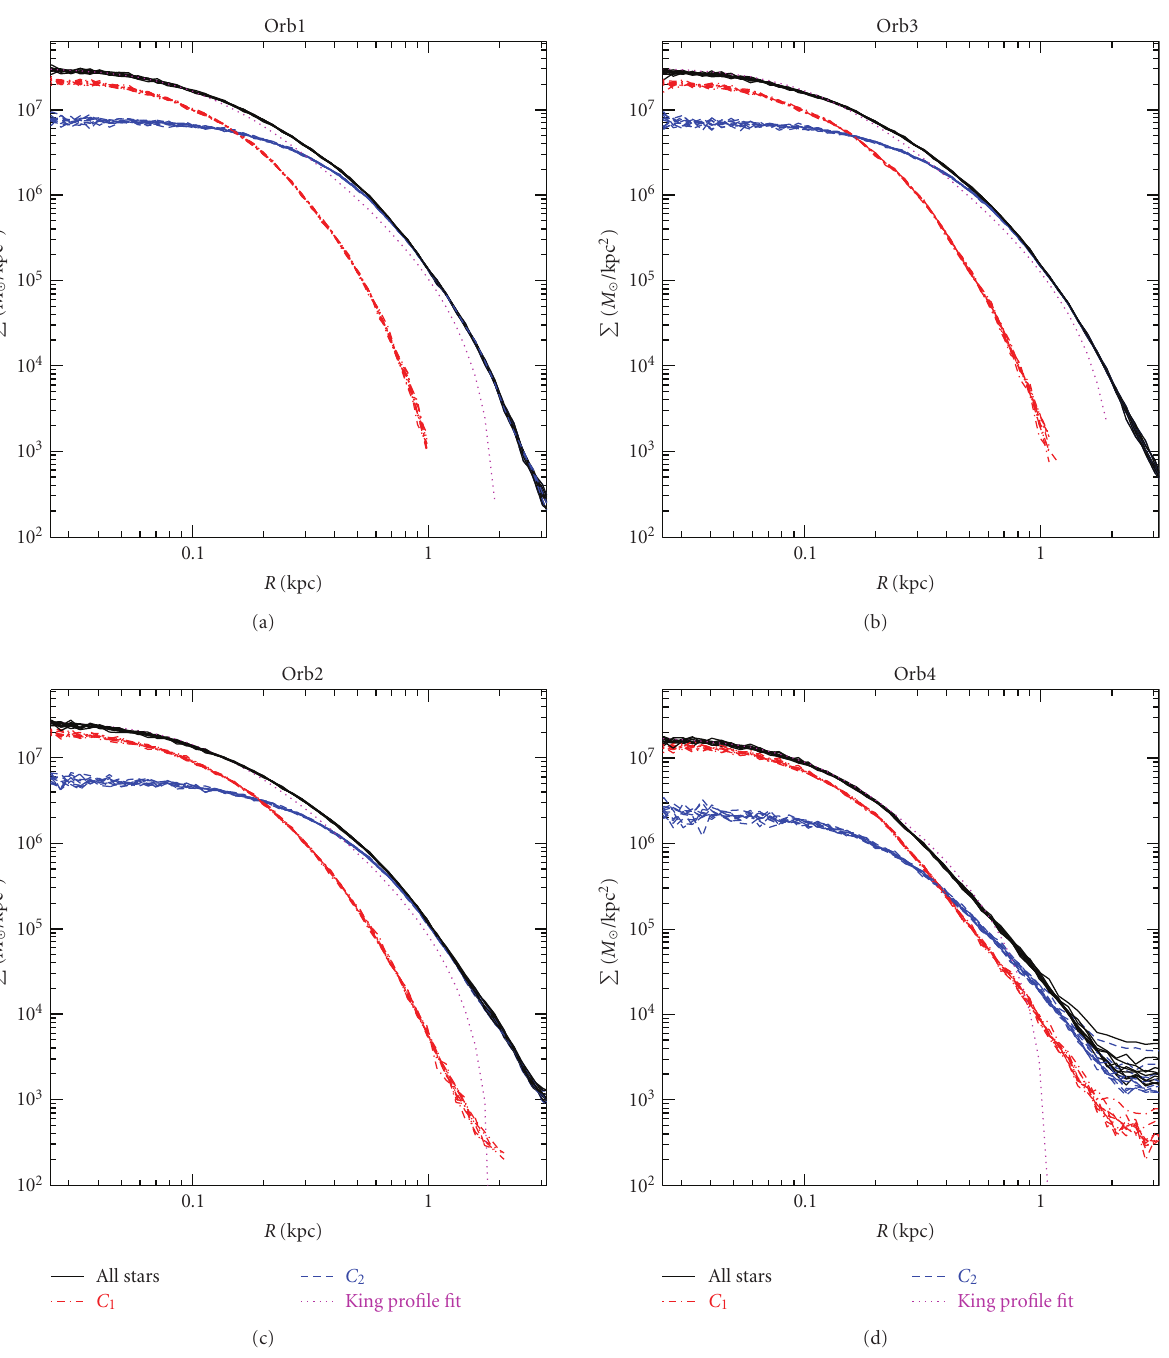
Figure 4: Surface mass density profiles of all our models after ∼ 6Gyr of integration in the host potential. The color codding is the same as that used in Figure